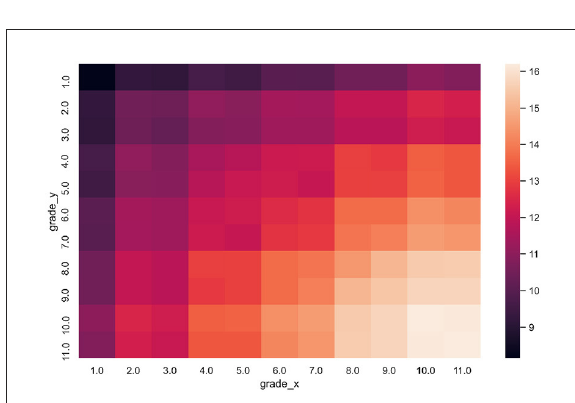
FIGURE2 The heatmap shows the number of sentence pairs ( x , y ) where sentence x has label “grade_x” and sentence y has label “grade_y” (in logarithmic scale).